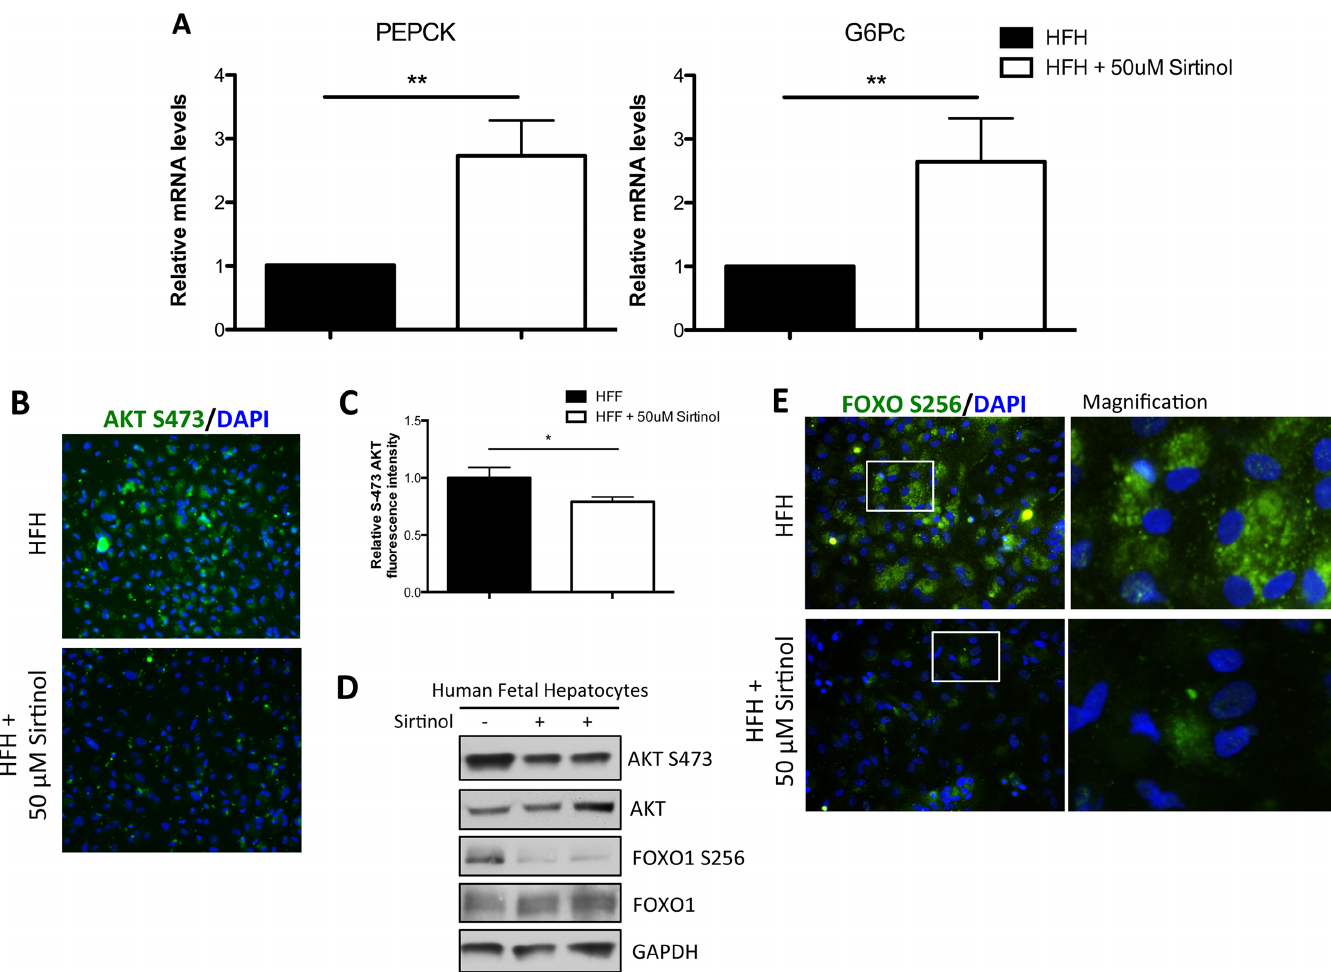
Fig 4. Increased activation of Glucogenesis pathway in human fetal hepatocytes after exposure to Sirtinol. (A) Expression of hepatic PEPCK and G6PC mRNA measured by qRT- PCR in human fetal hepatocytes exposed to +50uM Sirtinol compared to controls. (B) Immunofluorescence of S-473 AKT in human fetal hepatocytes with or without 50uM Sirtinol (10x). (C) Fluorescence intensity quantification for S-473 AKT signal (arbitrary units) using ImageJ (n (cid:1) 7/group; * , P < .05). (D) Western blot analysis for S-473 AKT/AKT, S-256 FOXO1/FOXO1 in human fetal hepatocytes exposed to 50uM Sirtinol compared to controls. GAPDH was used as a loading control. (E) Immunofluorescence staining of S-256 FOXO1 in human fetal hepatocytes with or without 50uM Sirtinol (20x).